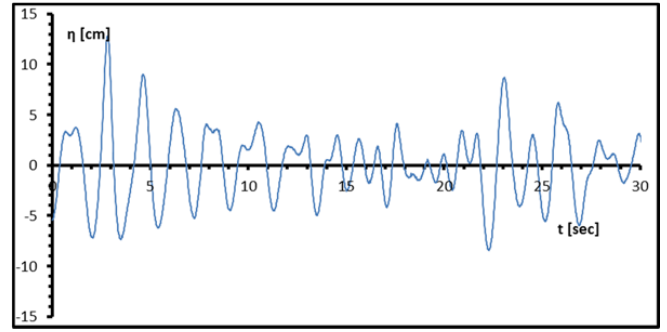
Figure 6. Water elevation η time series for Experiment #3.